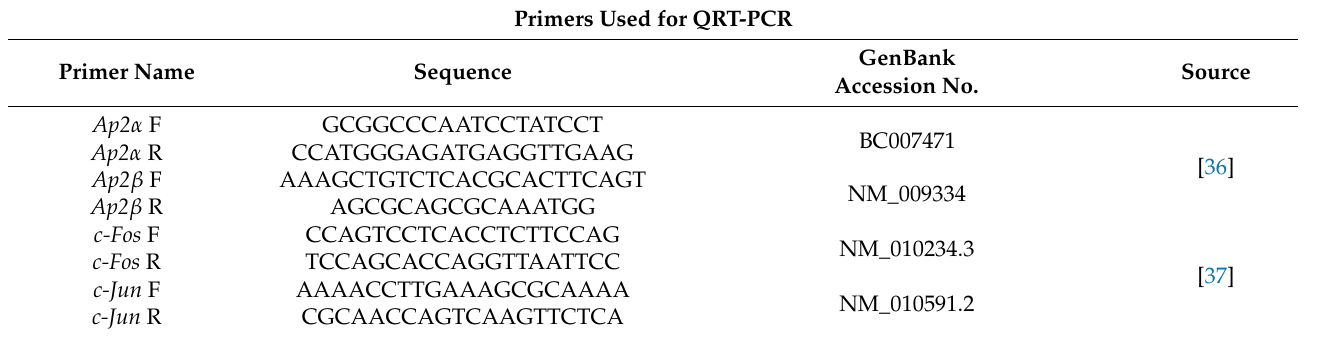
Table 1. List of primers used for quantitative RT-PCR and ChIP-qPCR. Primers Used for